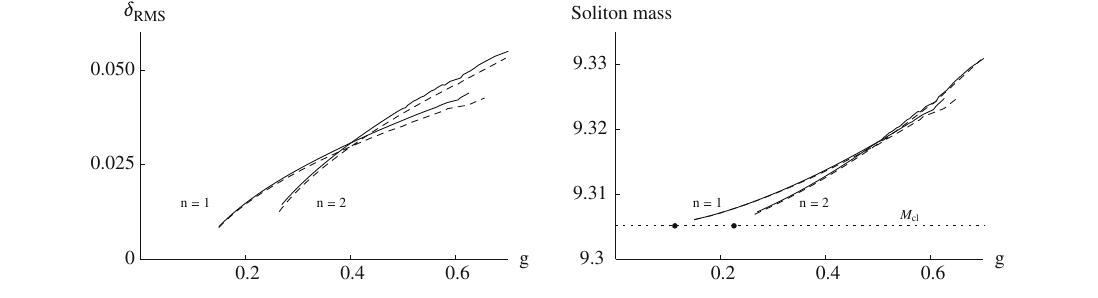
Fig. 2 Leftgraph δ RMS asafunctionofthecoupling g .The solidcurves denote the δ RMS for the first two positive energy levels and dashed ones for the first two negative energy levels. Right graph soliton mass as a function of the coupling g . The solid curves depict the soliton mass